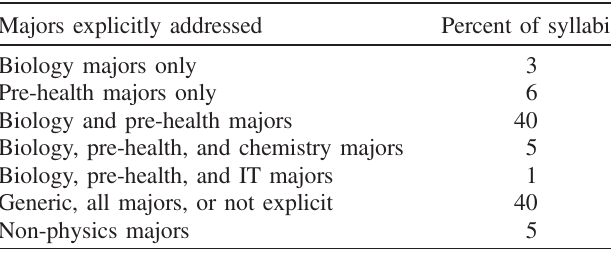
TABLE III. The percentage of the N ¼ 77 syllabi explicitly addressing students pursuing particular majors. This did not necessarily reflect whom the course was actually intended